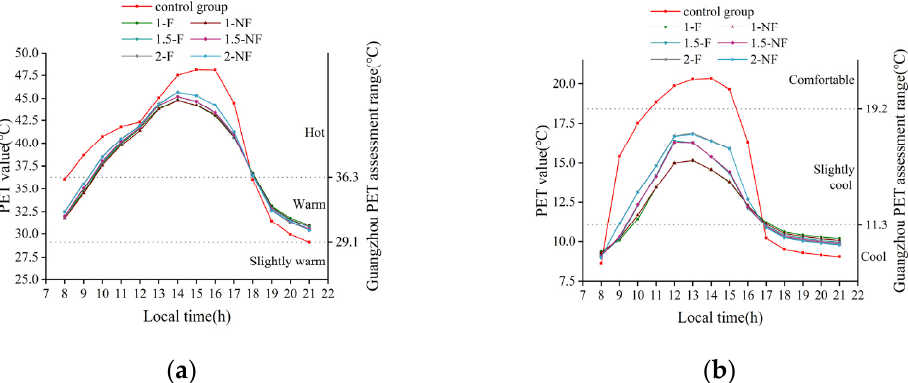
Figure 11. Effects of different arrangements of trees on outdoor thermal comfort in summer ( a ) and winter ( b ).